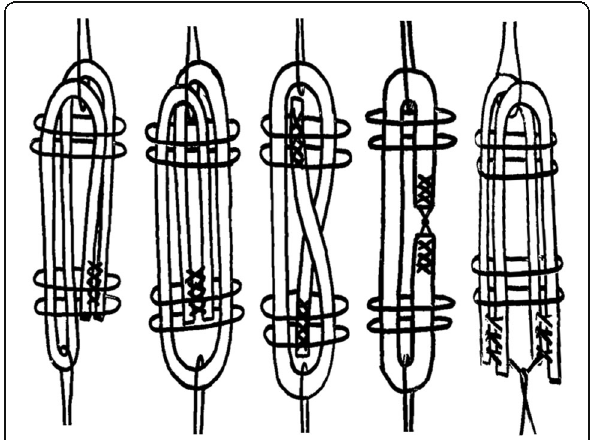
Fig. 1 Graft preparation techniques illustrated from left-to-right include: Quad-A: the two ends of the single graft are doubled over one suspensory suture, whipstitched together, and then passed together around another suspensory suture together. Quad-B: the two ends are passed in opposite directions around the second suspensory suture before the whipstitch is placed. Tripled: the graft ends are whipstitched separately, then each is passed around a suspensory suture, resulting in a whipstitch at each end of the construct. Folded: a single graft is whipstitched at each end, and the ends are each passed around a suspensory suture, meeting in the middle of the construct. Two-Doubled: two grafts are selected, and doubled over a suspensory suture. The whipstitched ends are then secured to a separate suspensory suture by way of knots tied in the whipstitch tails. The femoral end of each graft is depicted at the top of the schematic, and the tibial end is at the